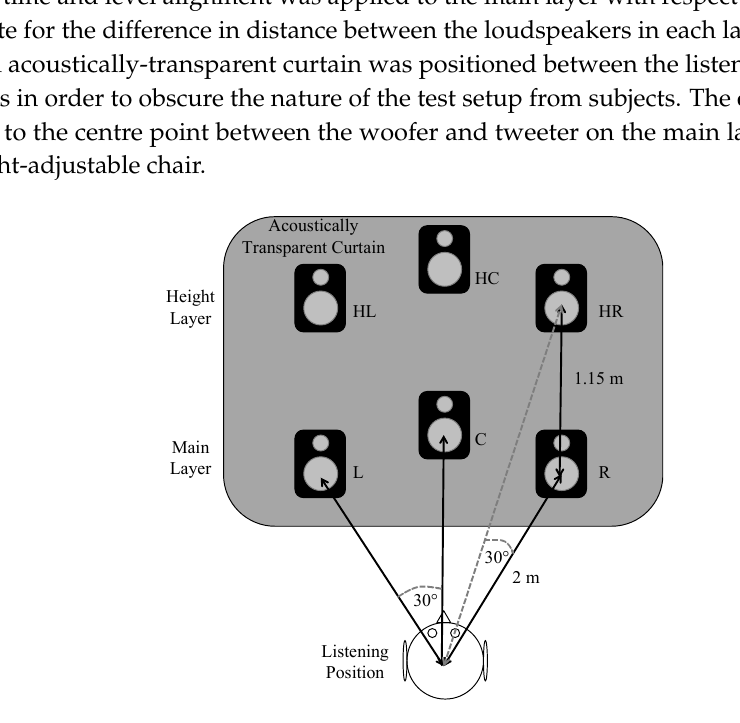
Figure 1. The physical setup used for Experiment One. C: centre loudspeaker; L: left loudspeaker; R: right loudspeaker; HC: height centre loudspeaker; HL: height left loudspeaker; HR: height right loudspeaker.